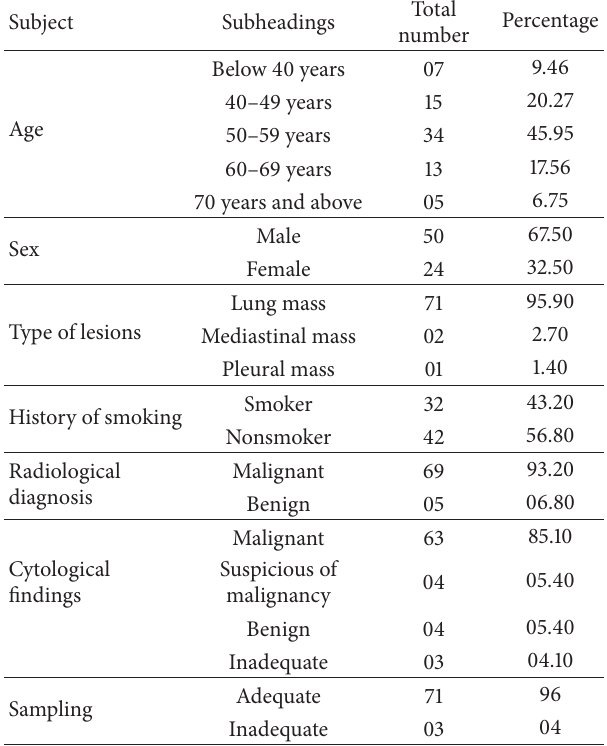
Table 1: The demographic description of the